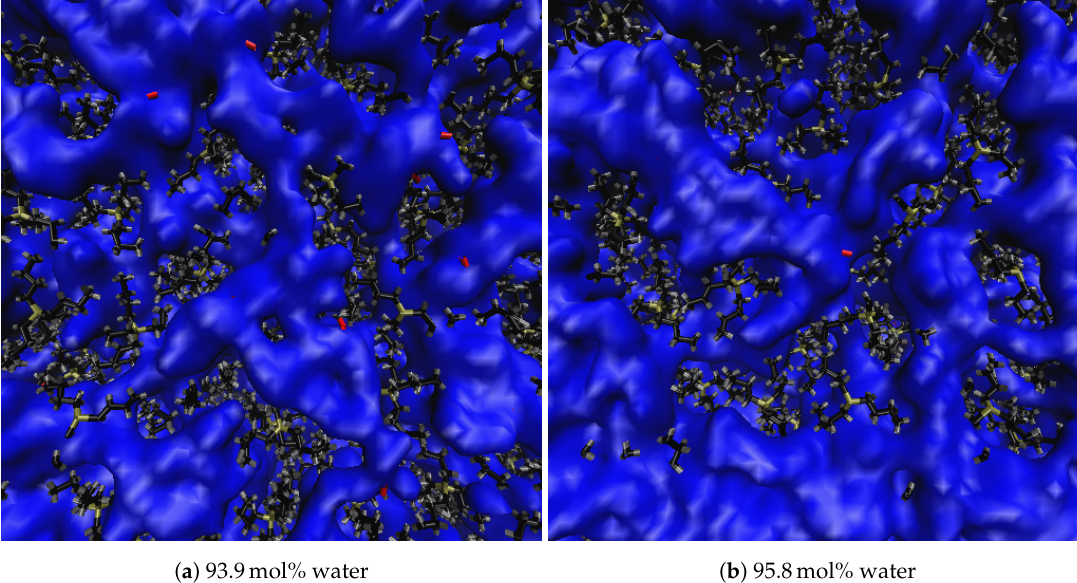
Figure 10. Water veins and channeling in TBPH at 320K (Part 2 of 2) [27,28]. The Figures represent the changing water structure with increasing water concentration: ( a ) 93.9mol% water; ( b ) 95.8mol% water. The blue-colored water is represented using an isosurface drawing method (called quicksurf in visual molecular dynamics (VMD) [13]), which uses a volumetric Gaussian density map of the water to produce the observable surface. The tetrabutylphoshonium hydroxide (TBP) and OH molecules are represented using the dynamic bonds drawing method in VMD [13]. TBP is colored tan, black and gray, for the phosphorus, carbon, and hydrogen atoms, respectively. The hydroxide is colored in red for both the oxygen and hydrogen atom.